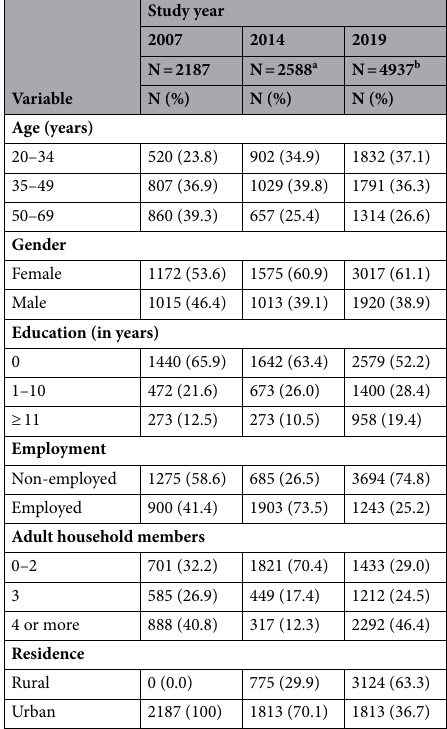
Table 1. Sample characteristics of participants aged 20–69 years, Bhutan, 2007, 2014, and 2019. Unweighted %; a 20 (0.8%) were excluded due to history of CVD; b 168 (3.3%) were excluded due to history of